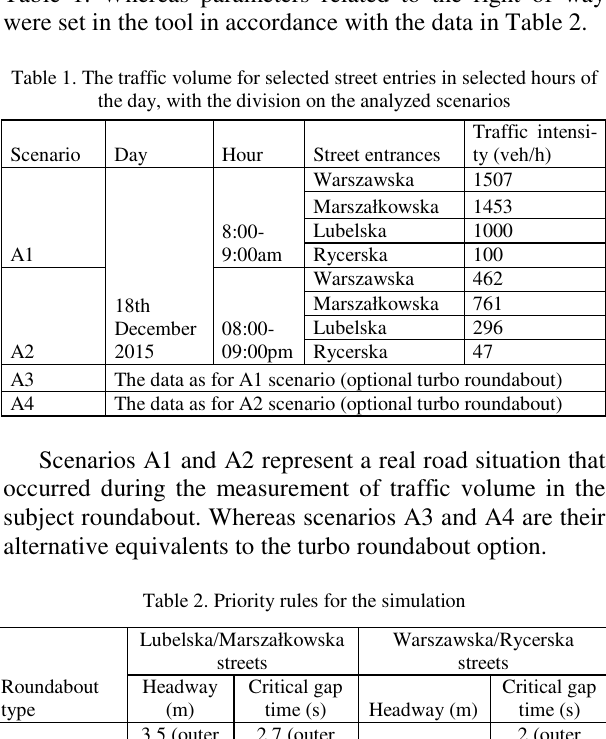
Roundabout type